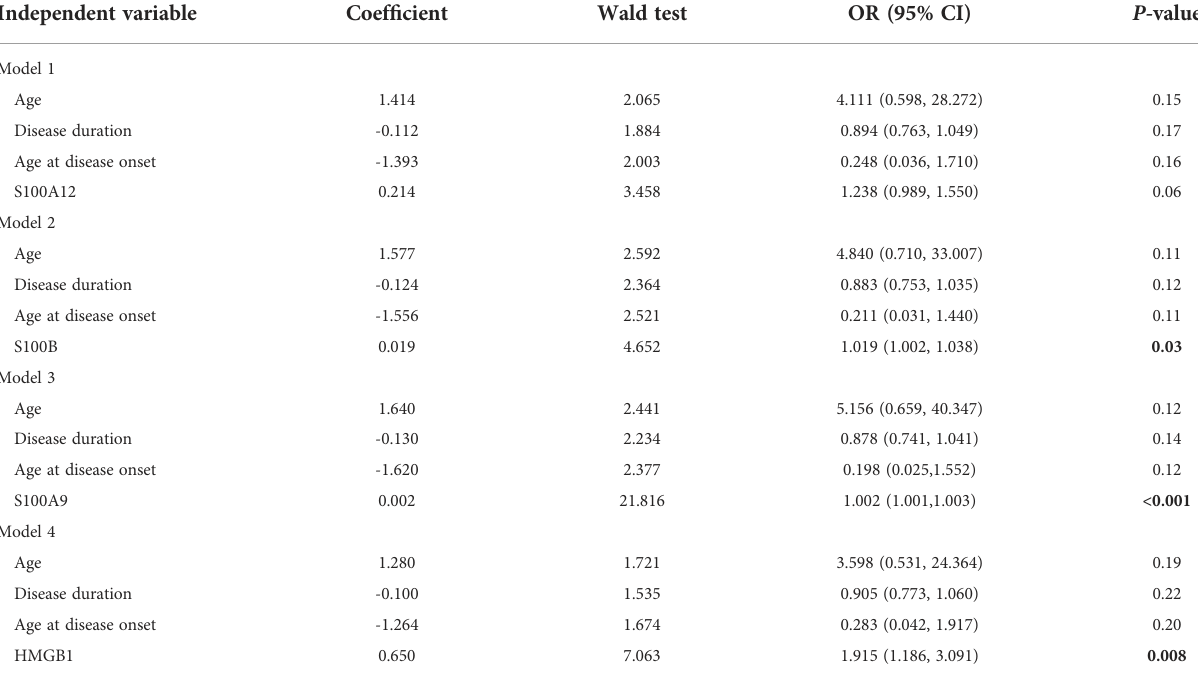
TABLE 3 Multivariate models investigating the association of S100A12, S100B, S100A9, HMGB1, and disease activity.